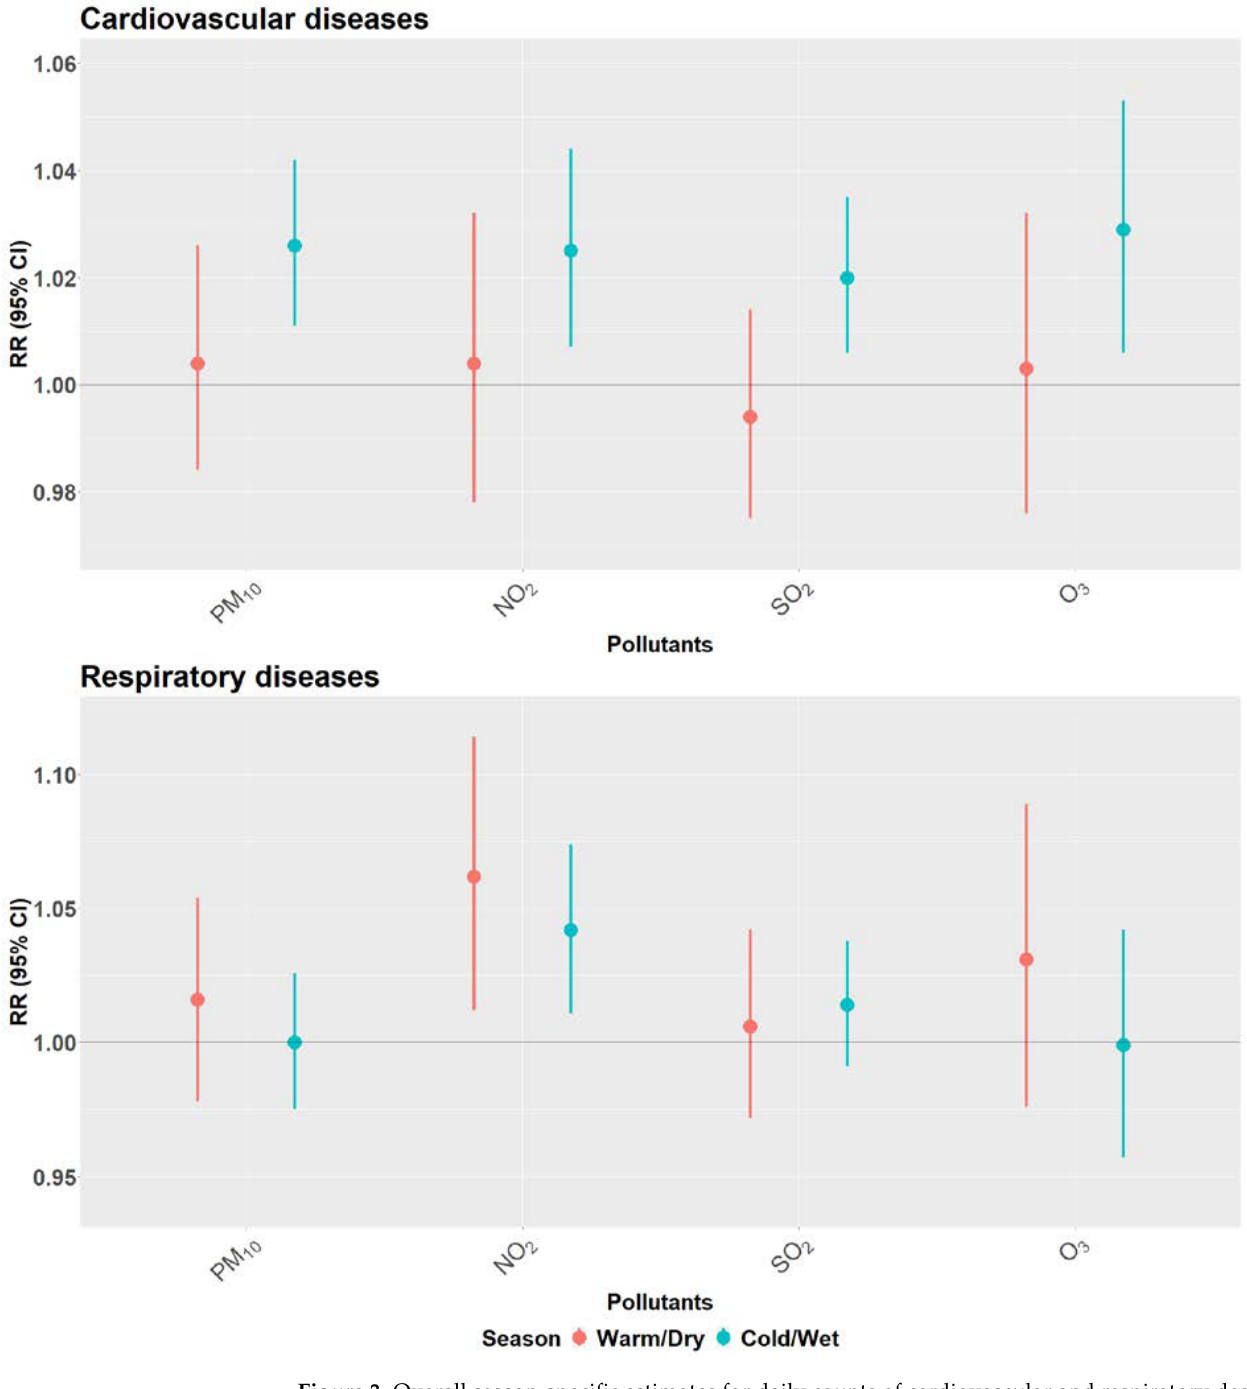
Figure 3. Overall season-specific estimates for daily counts of cardiovascular and respiratory deaths from Quasi-Poisson regression models adjusting for time trends and seasonal variation, day of the week, public holiday, temperature and relative humidity. Estimates are presented per IQR µg/m 3 increase in the two-day moving average (lag 0–1) of PM 10 , NO 2 , SO 2 and O 3 .